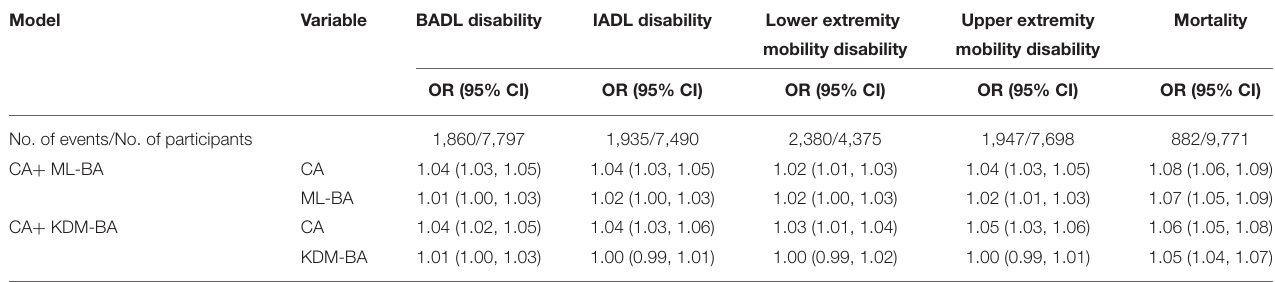
TABLE 4 | Risk estimates of physical disability and mortality predicted by ML-BA and KDM-BA adjusting for CA.